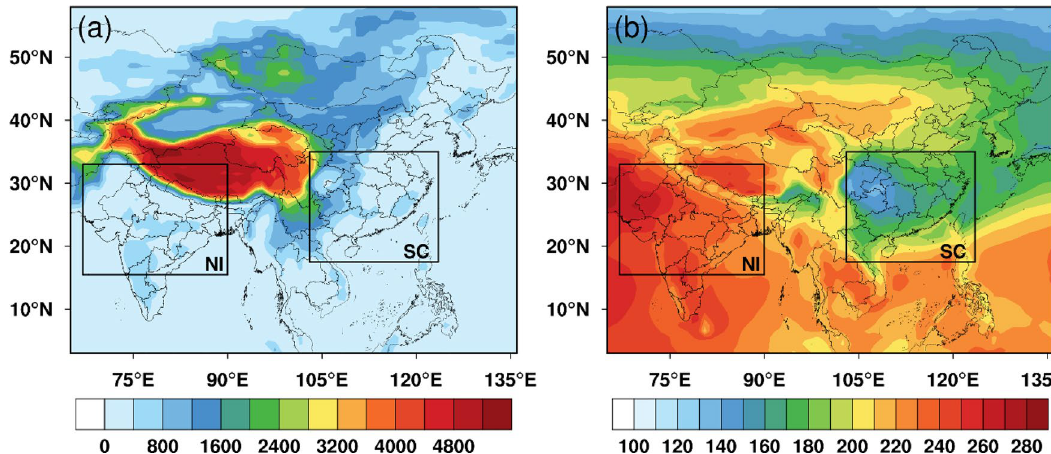
Figure 1. The ( a ) surface altitude (Unit: m) and ( b ) annual averaged downward shortwave irradiance at the surface (Unit: W/m 2 ) over southern China and northern India from 2003 to 2019 based on the CERES